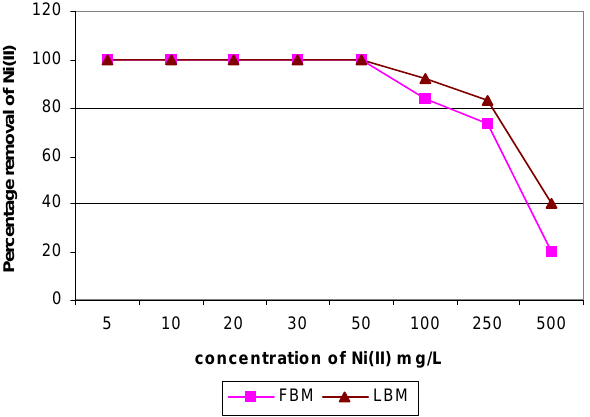
Figure 7: Loading capacity determination of Ni(II)